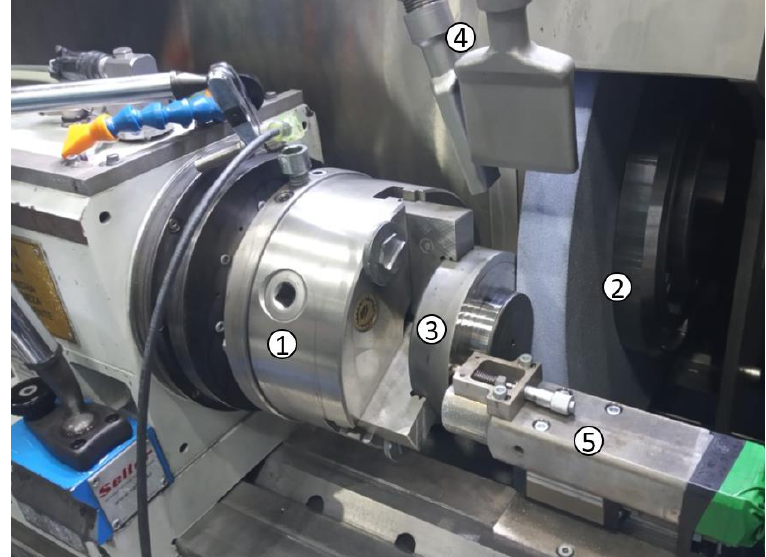
Figure 7. Machine and in-process eddy current inspection set-up.